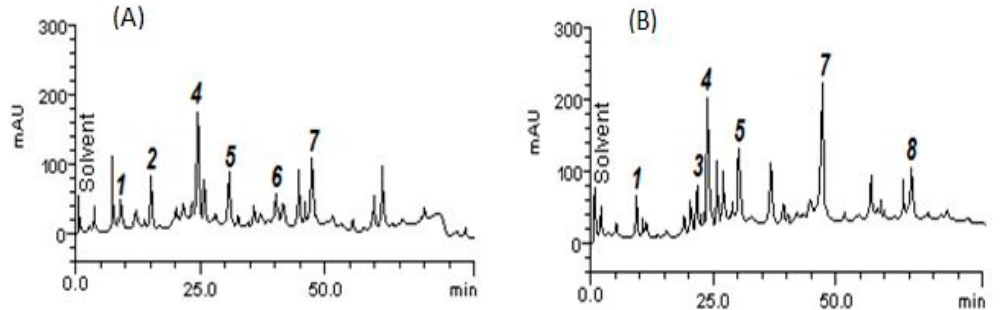
Figure 1. Representative sample of reverse phase HPLC analysis of the Mesosphaerum suaveolens extracts: ( a ) chromatogram of the Mesosphaerum suaveolens aqueous leaf extract (AELMs) showing its peaks; ( b ) chromatogram of the Mesosphaerum suaveolens aqueous aerial parts extract (AEAPMs) showing its peaks. Gallic acid (peak 1), catechin (peak 2), chlorogenic acid (peak 3), caffeic acid (peak 4), ellagic acid (peak 5), rutin (peak 6), quercetin (peak 7), and apigenin (peak 8). Table 1. Chemical composition of the Mesosphaerum suaveolens extracts by HPLC-DAD. AELMs Compounds